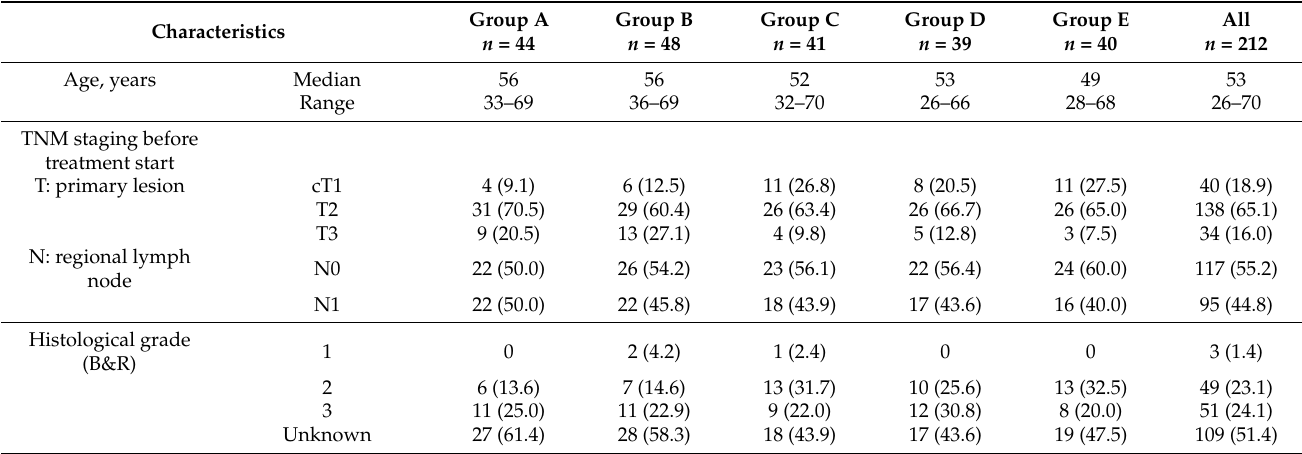
Table 1. Patient characteristics ( n =